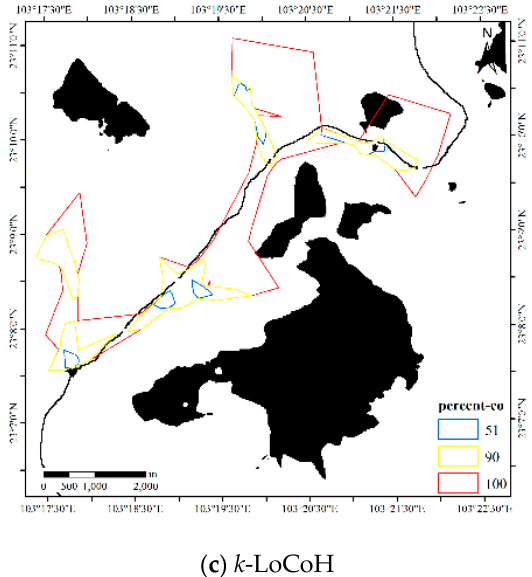
Figure 20. HRs of the DFHRE, MKDE and k -LoCoH methods for Dataset 2.